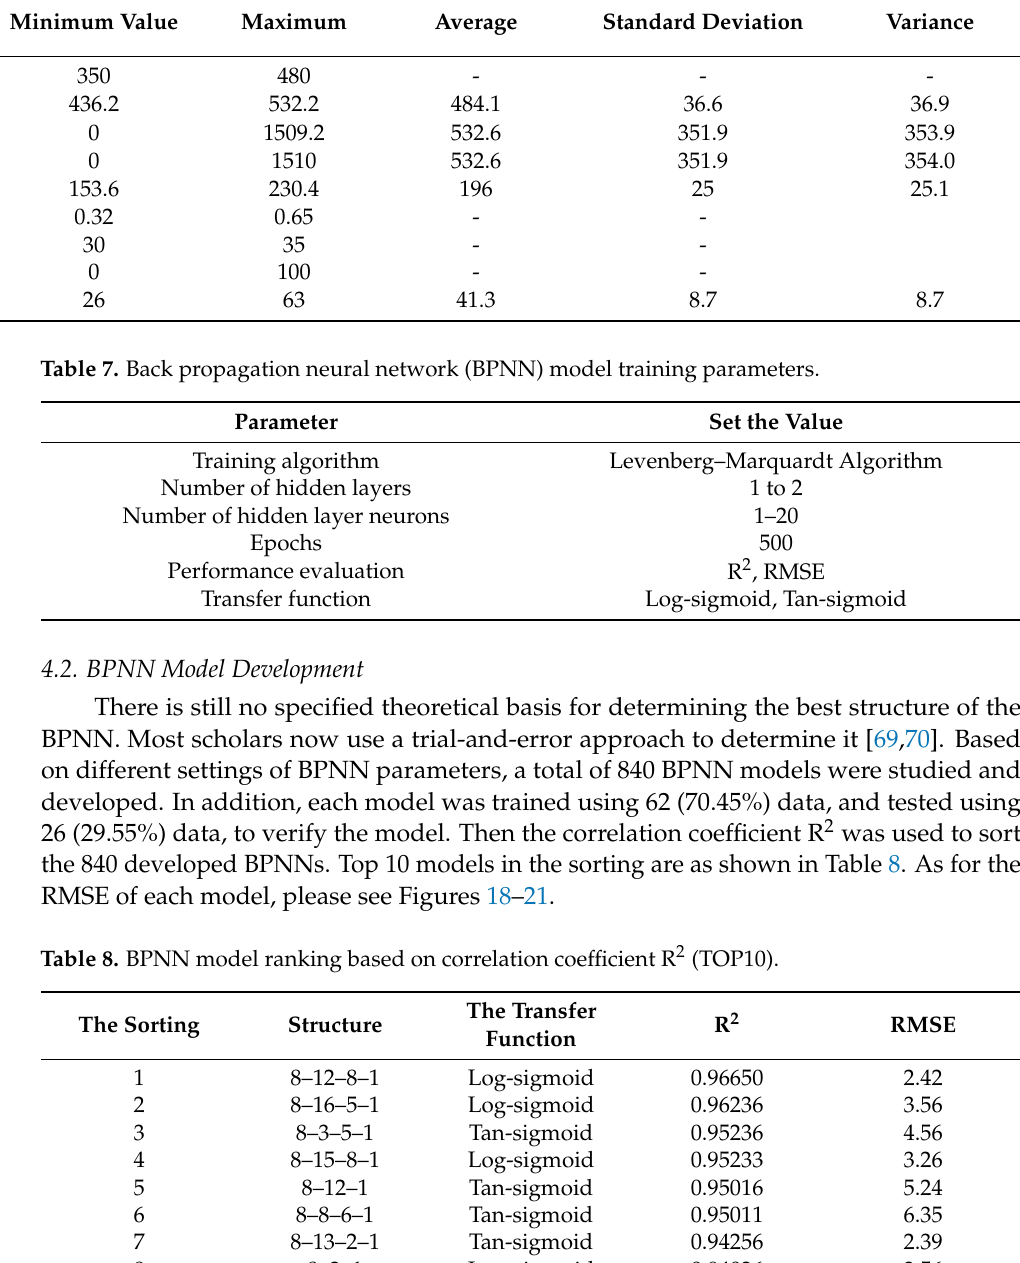
the training status of